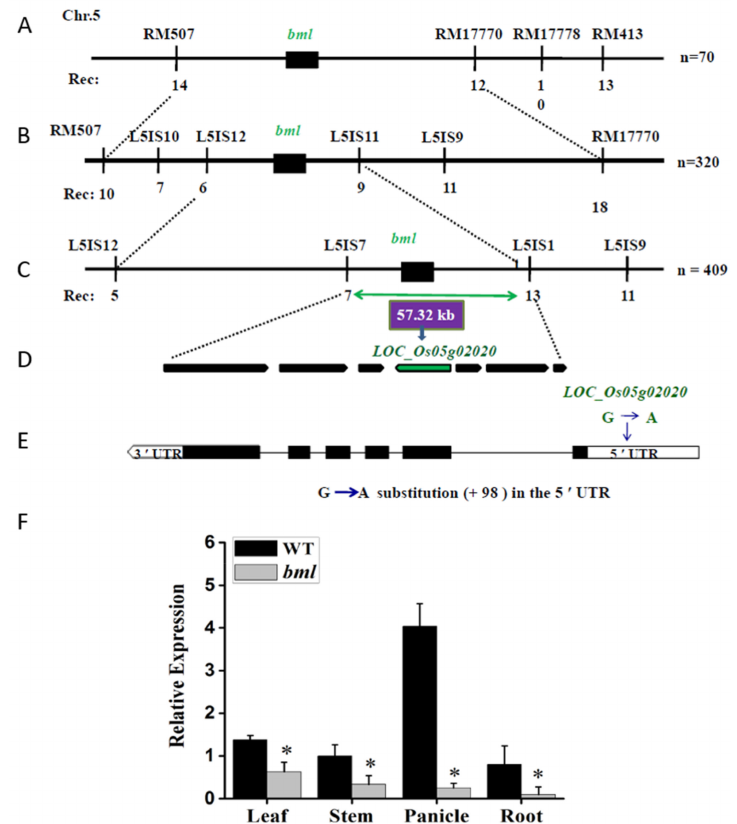
Figure 2. Map-based cloning of the BML locus. ( A ) Primary mapping between two markers, RM507 and RM17770 (linked to BML ), on the short arm of chromosome 5. Seventy F 2 individuals of the mutant were used; the corresponding number of recombinants is listed (below the vertical lines). ( B ) Using 320 F 2 BML mutant individuals, BML was primarily mapped to a region between the markers L5IS12 and L5IS11. ( C ) Finally, using 409 F 2 mutant individuals, BML was fine-mapped to a 57.32 kb interval region between the markers L5IS7 and L5IS11. ( D ) Seven genes were annotated in the 57.32 kb candidate region; LOC_Os05g02020 was presumed to be BML . ( E ) The structure of the BML gene and the locus of the mutation are marked. Black boxes indicate exons, and lines indicate introns. ( F ) Expression patterns of BML in rice leaf, stem, panicle, and root at the heading stage. The rice actin gene was used as a reference. All data are shown as means ± standard deviation (SD) of five replicates; * p < 0.05 by Tukey’s